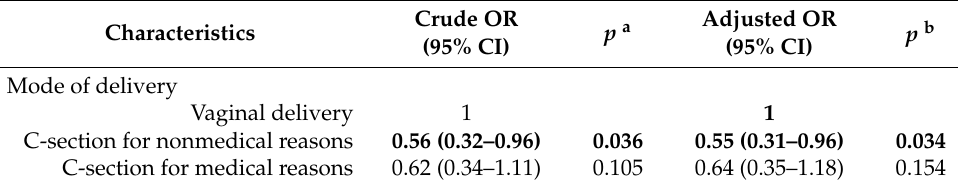
Table 3. Association between breastfeeding intentions and having a cesarean section.